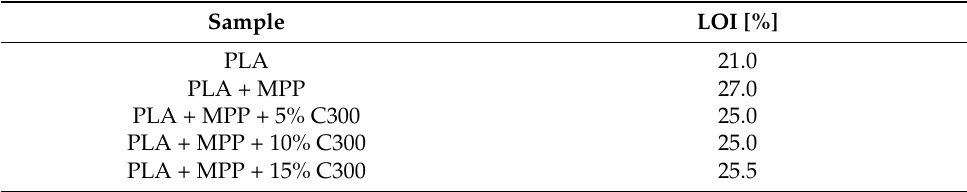
Table 4. LOI values of the composite samples with differing neat cellulose content.